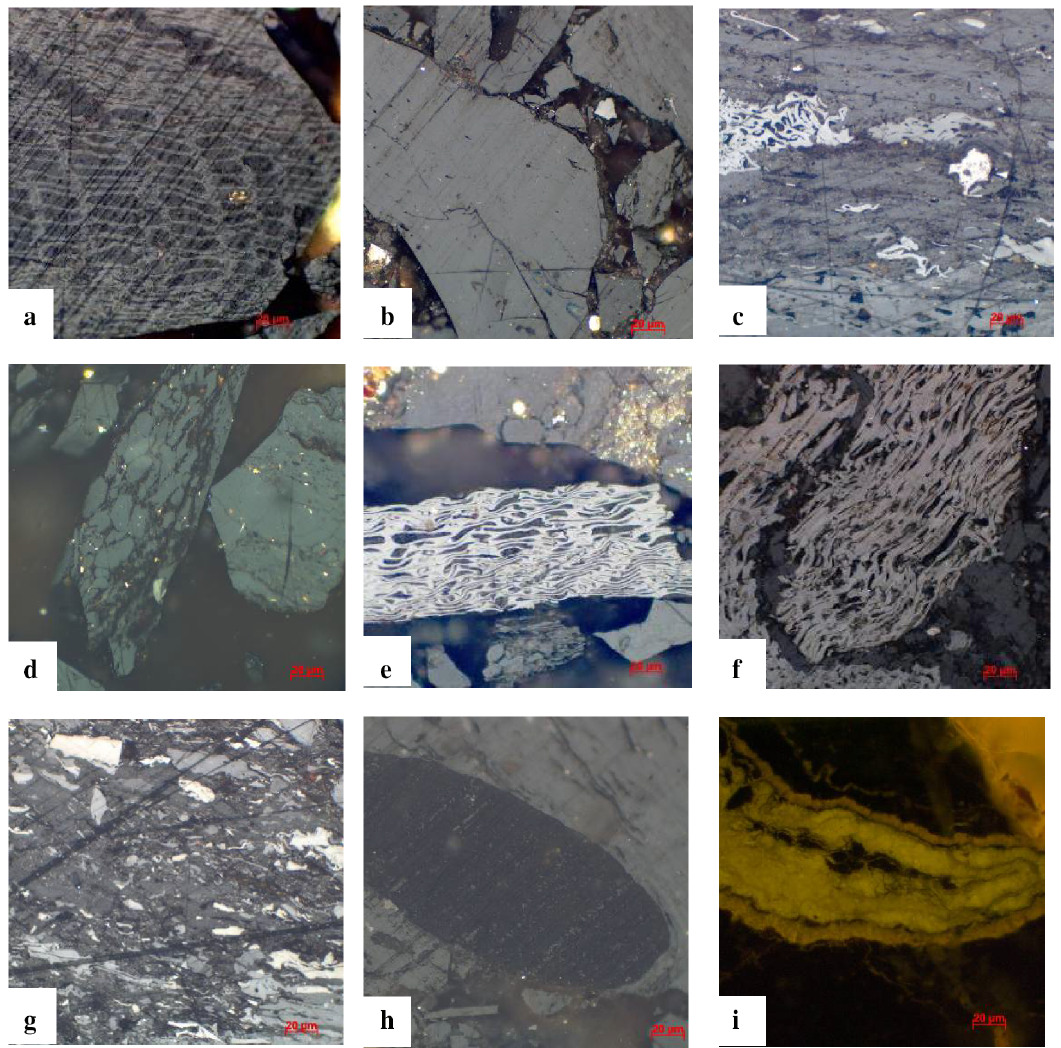
Fig. 2 Photomicrographs in white reflected light (oil immersion) ( a – h ) and fluorescing-inducing blue light ( i ) coal seams in Santanghu Coalfield. a Telinite showing well-preserved cell structure; b Telocollinite with inertodetrinite; c Desmocollinite with semifusinite; d Corpocollinite with pyrite; e the cell cavity of Fusinite filled with vitrodetrinite; f Semifusinite with desmocollinite; g Vitrodetrinite and inertodetrinite; h Resinite in the shape of ellipsoid; i Sporinite of the shape flat